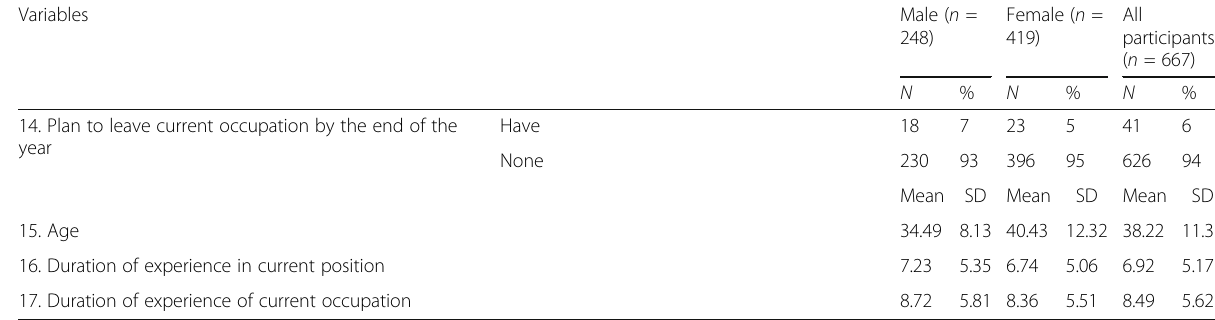
Table 1 Basic attributes and characteristics of study participants ( N = 667) a. (Continued) Variables